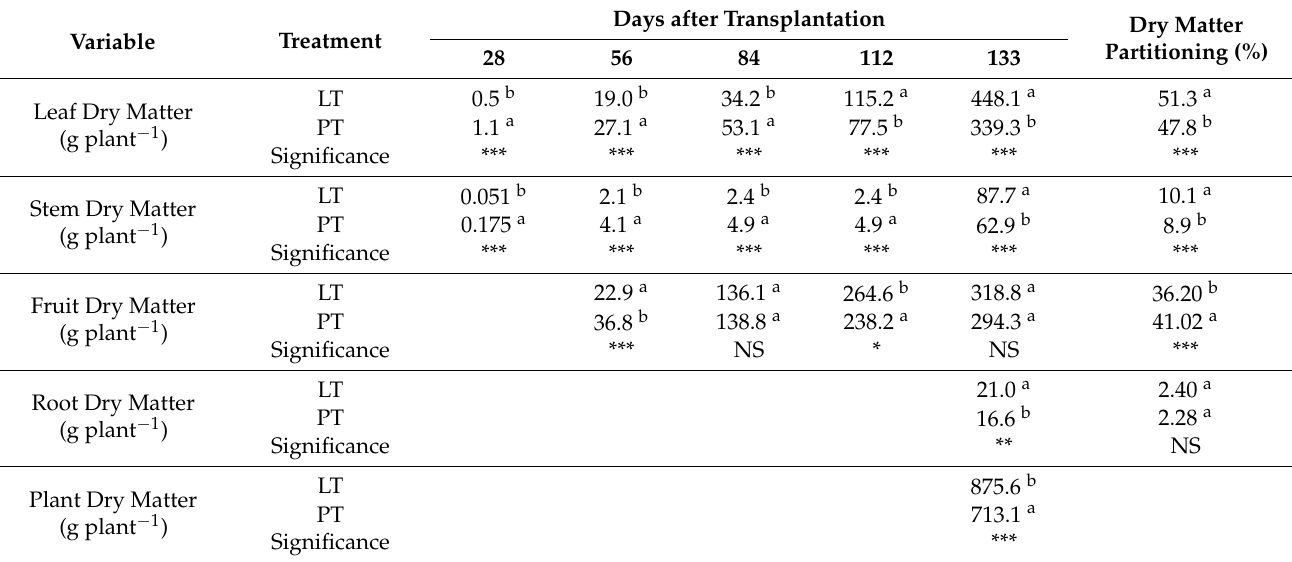
Table 3. Effects of training methods on leaf, stem, fruit, and roots dry weight and dry matter distribution to plant